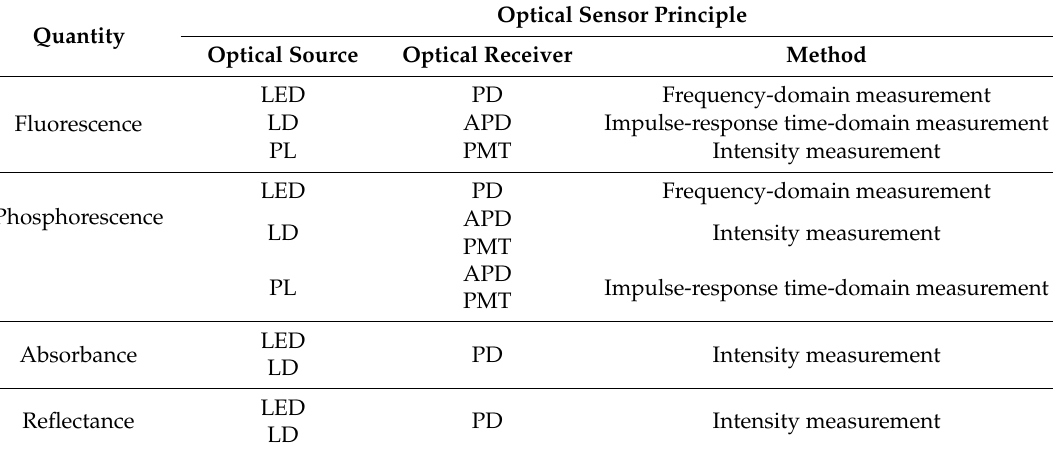
Table 1. Examples of typical configuration of optical sensors for sensing four quantities: fluorescence, phosphorescence, absorbance, and reflectance (LED: Light-Emitting Diode; LD: Laser Diode; PD: Photo Diode; APD: Avalanche Photodiode; PMT: Photomultiplier Tube; PL: Pulsating